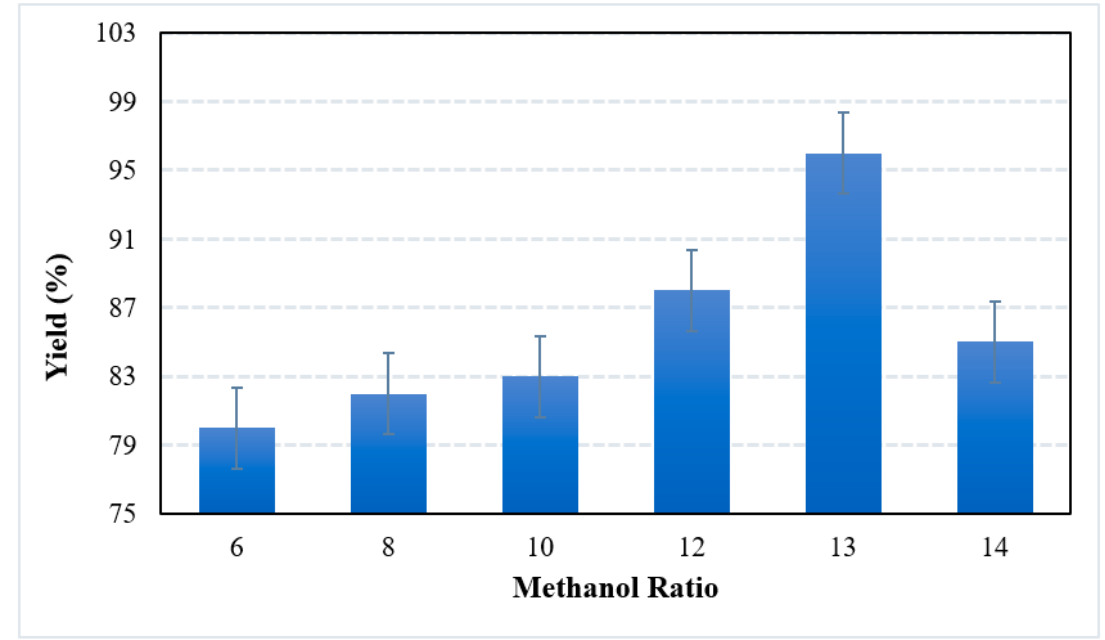
Figure 6. Effect of methanol to oil ratio on biodiesel production.